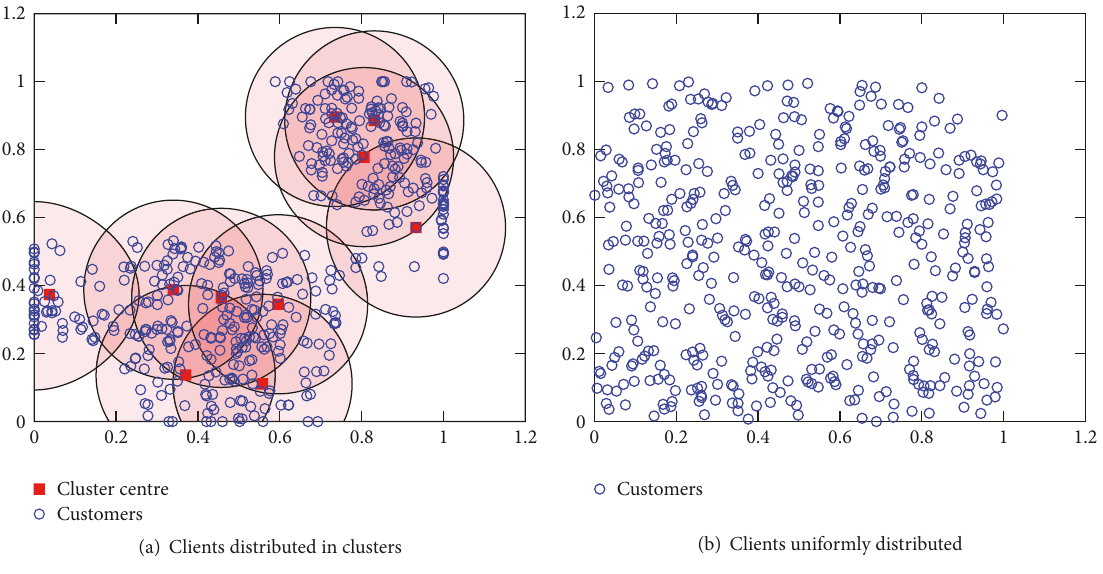
Figure 3: Example of the instances considered in this study. Table 1: Instances for the first benchmark used in this study (OR Library). OR